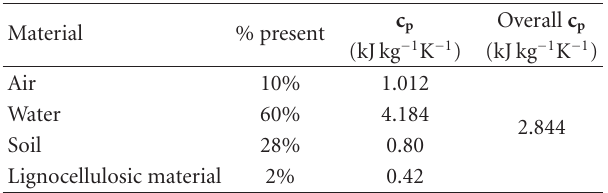
Table 1: Estimated material composition for composting at